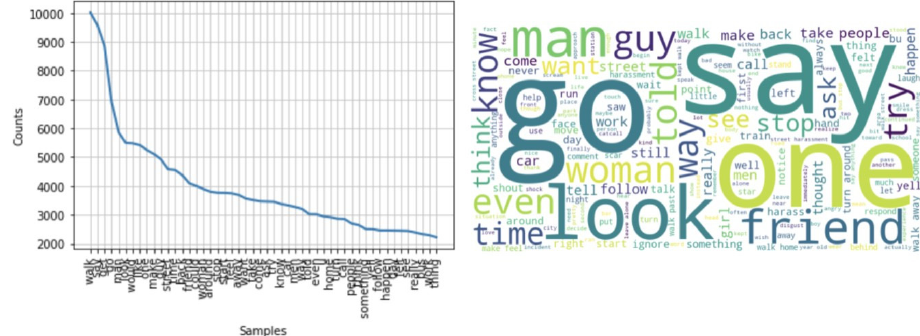
Figure 13. Bag-of-words representation model.